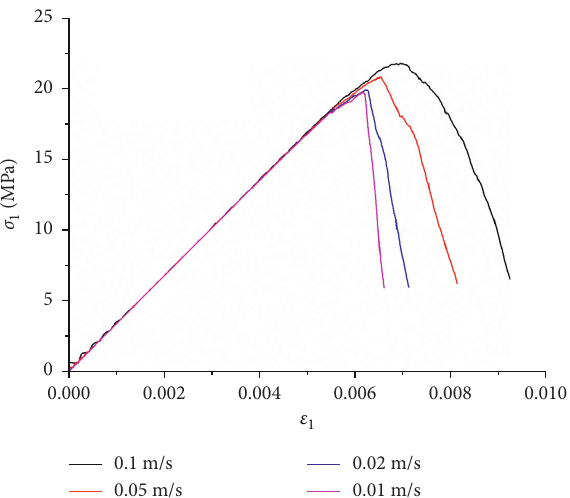
Figure 2: Conventional compression simulation stress-strain curves under different loading rates. Symbols σ 1 and ε 1 represent the axial stress and axial strain, respectively.